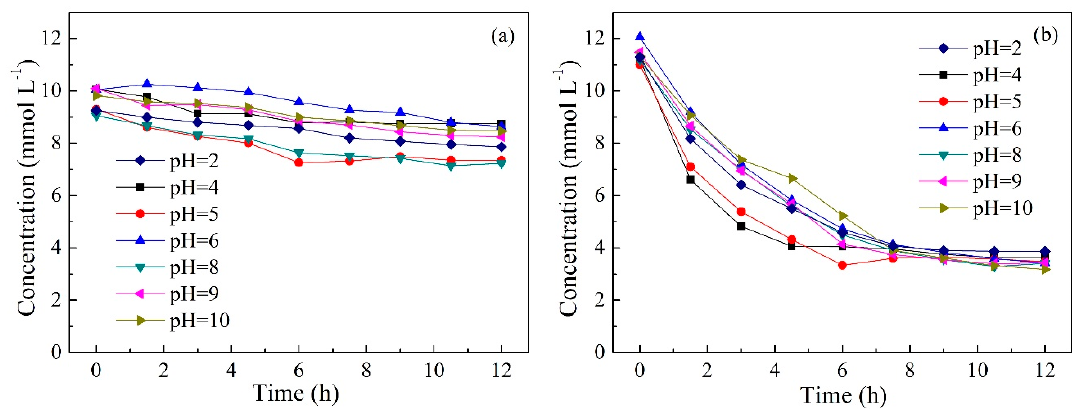
Figure 6. The changes in ( a ) acetic acid and ( b ) hexanoic acid concentrations in the feed solution with di ff erent initial pH (PIMs: PIM4; Feed solution: 0.01 mol L − 1 acetic acid + 0.01 mol L − 1 hexanoic acid; Stripping solution: 0.1 mol L − 1 HCl). Table 1. Permeability coe ffi cient (P) and purity at di ff erent pH values.